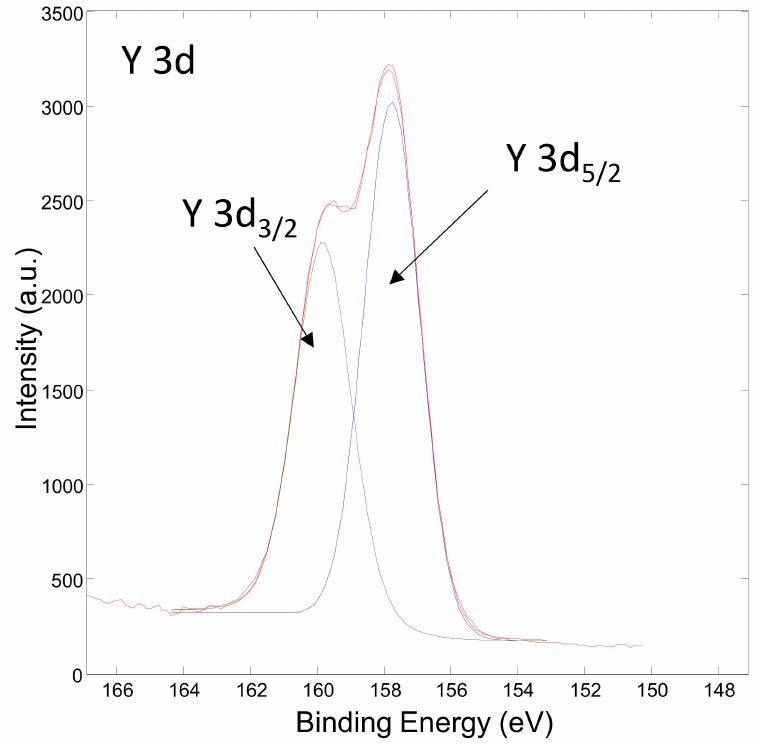
Figure 10. XPS spectrum of Y 3d obtained after removing the 10-nm thick layer on the concentrated sample Ni/Y 2 O 3